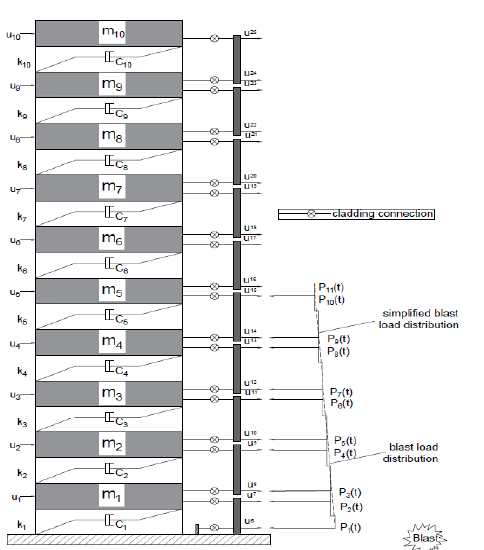
Fig. 2. Simulated structures with cladding panels.